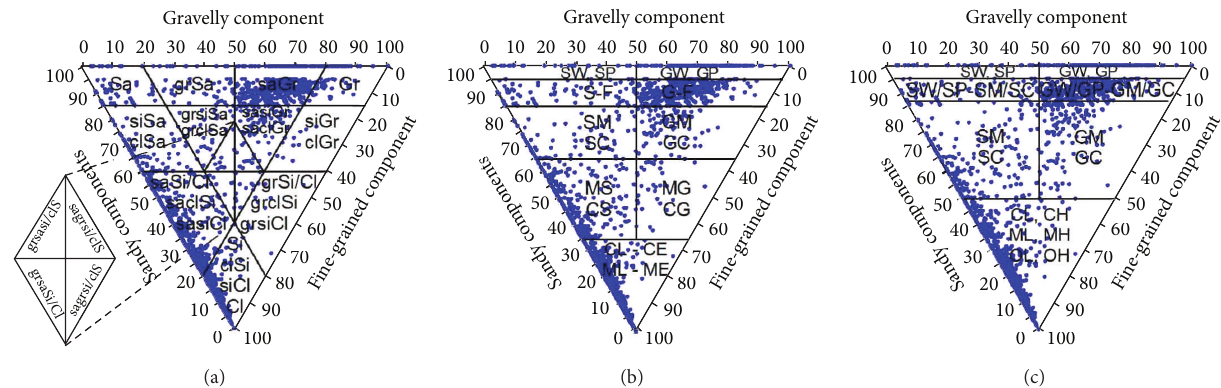
Figure 3: Gr: gravel, Sa: sand, Si: silt, Cl: clay; gr: gravelly, sa: sandy, si: silty, cl: clayey. European, Czech, and USCS classification system of soils with marked studied samples: (a) the European soil classification system [20]; (b) the Czech soil classification system [21], and (c) the Unified Soil Classification System [22].